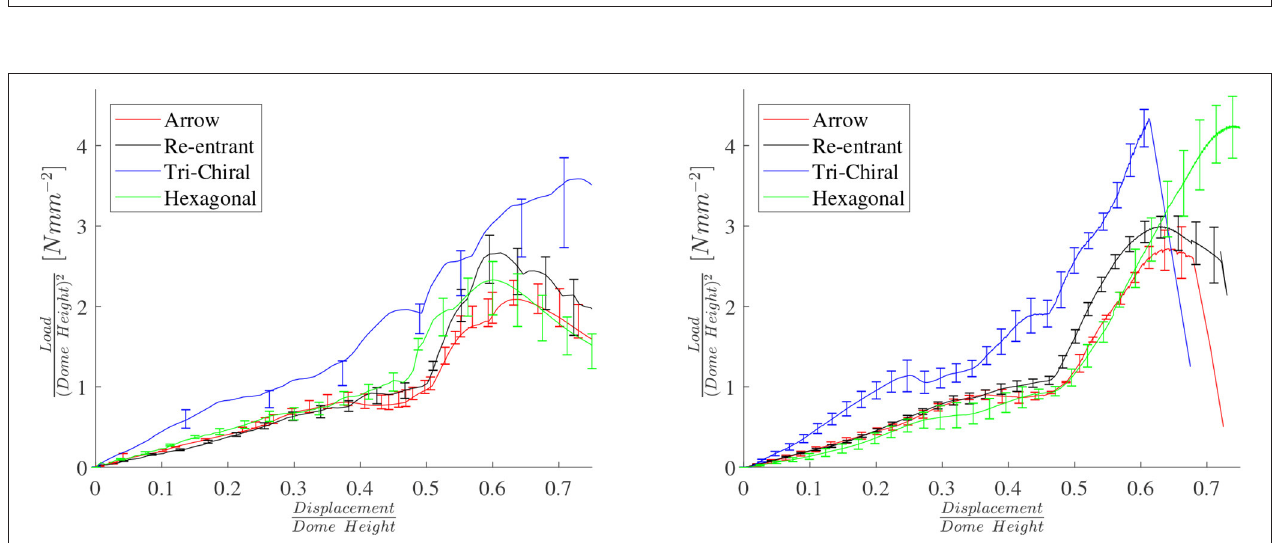
FIGURE 14 | FE (Left) and experimental (Right) load/displacement curves from buckling tests for 4 dome topologies.